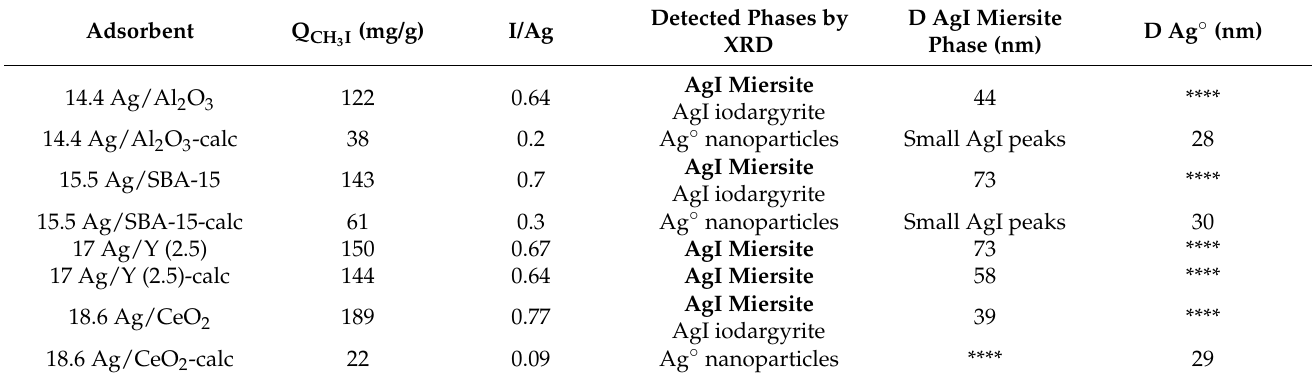
Table 3. Adsorption properties toward CH 3 I of the investigated calcined and not calcined silver-impregnated supports (the major AgI phase is indicated in bold, the symbol **** means that the presence of AgI or Ag ◦ phases were not detected). Detected Phases by Adsorbent Q CH (mg/g) I/Ag 3 I